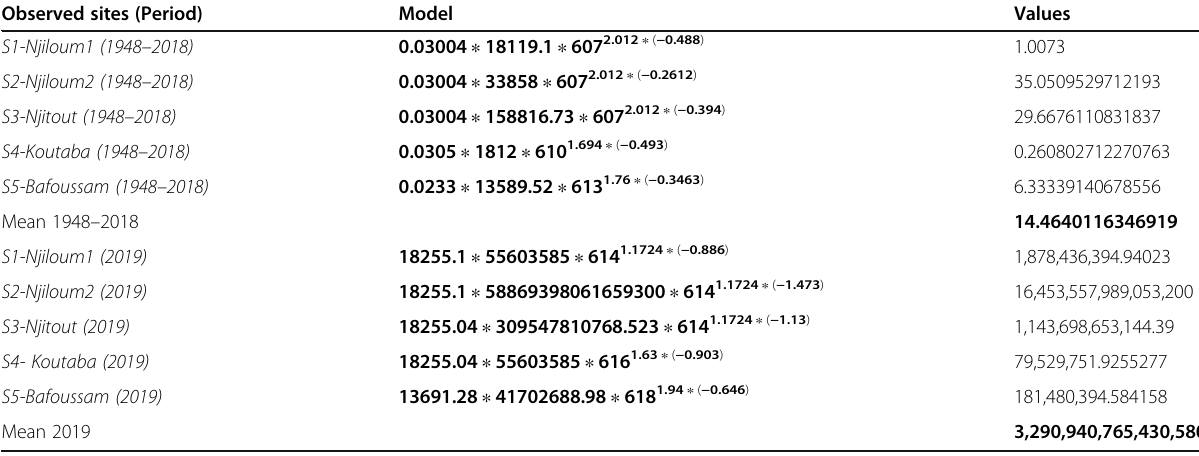
Table 6 Equations of ANOVA regression for the observed sites Observed sites (Period) Model